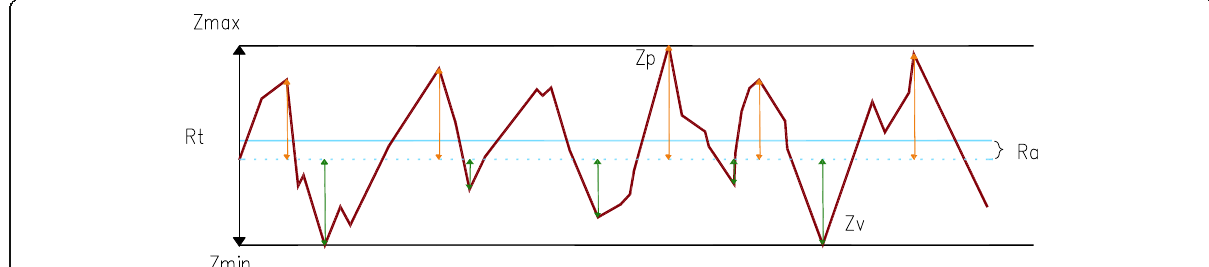
Fig. 5 Schematic view of a topographic profile showing the elements to define Ra and Rt roughness parameters. Blue dotted line: base line of the profile; Zp: height of the highest peak; Zv: deepest valley; Zmax: parallel line of the baseline that marks; Zmin: line parallel to the baseline that marks the deepest valley; brown arrows: the five highest peaks; green arrows: the five deepest valleys